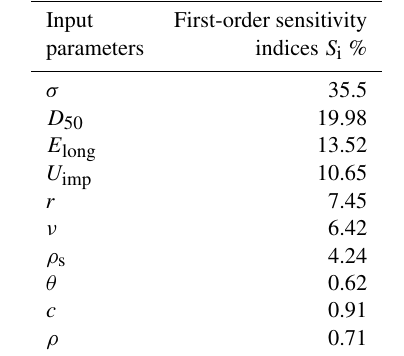
Table 2. First-order sensitivity indices S i computed by the FAST method, assuming the peak frequency as the output of the model, f peak : 0% means no influence, and 100% means total influence on the model